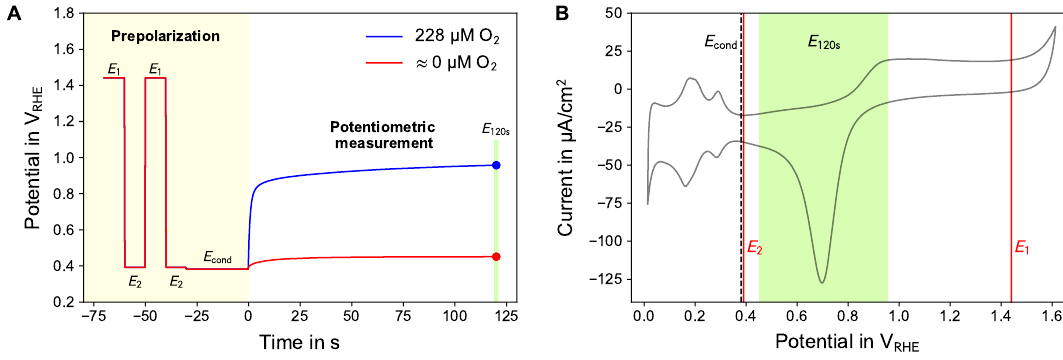
Figure 1. ( A ) One cycle of the active potentiometry comprising a prepolarization phase (marked, left region) and the potentiometric measurement phase (unmarked, right region). The results shown in this figure were obtained with E cond = 0.38V RHE resulting in good oxygen sensitivity during the potentiometric phase. The potentiometric phase lasts for 120s in which the measurement value is taken at its end ( E 120s ) providing one data point per repetition. The blue curve was obtained in air-saturated and the red curve in nitrogen-flushed PBS. ( B ) Overlay of the potentials from A over a cyclic voltammogram of platinum in air-saturated PBS to illustrate the different potential